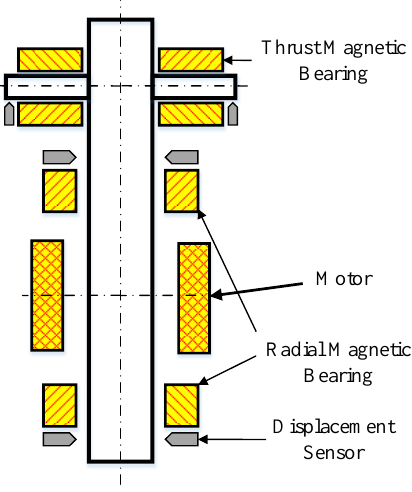
Figure 2. The schematic diagram of vertical AMBs.